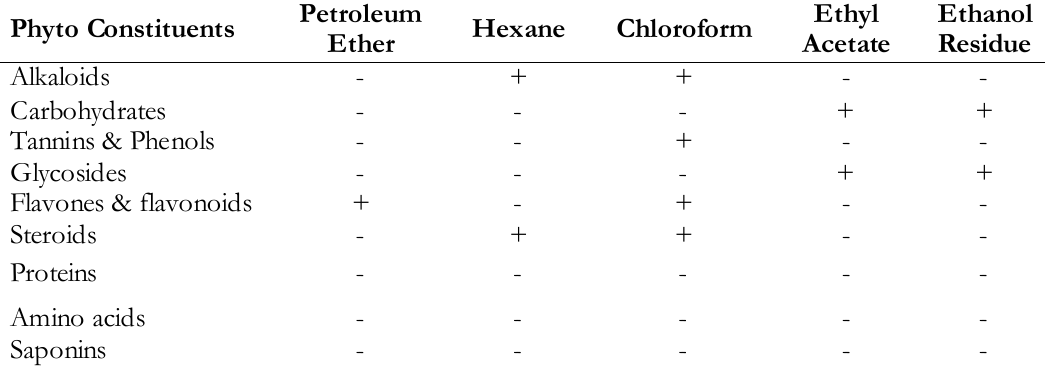
Table I. Phytochemical investigation on fractions of Hydrolea zeylanica.